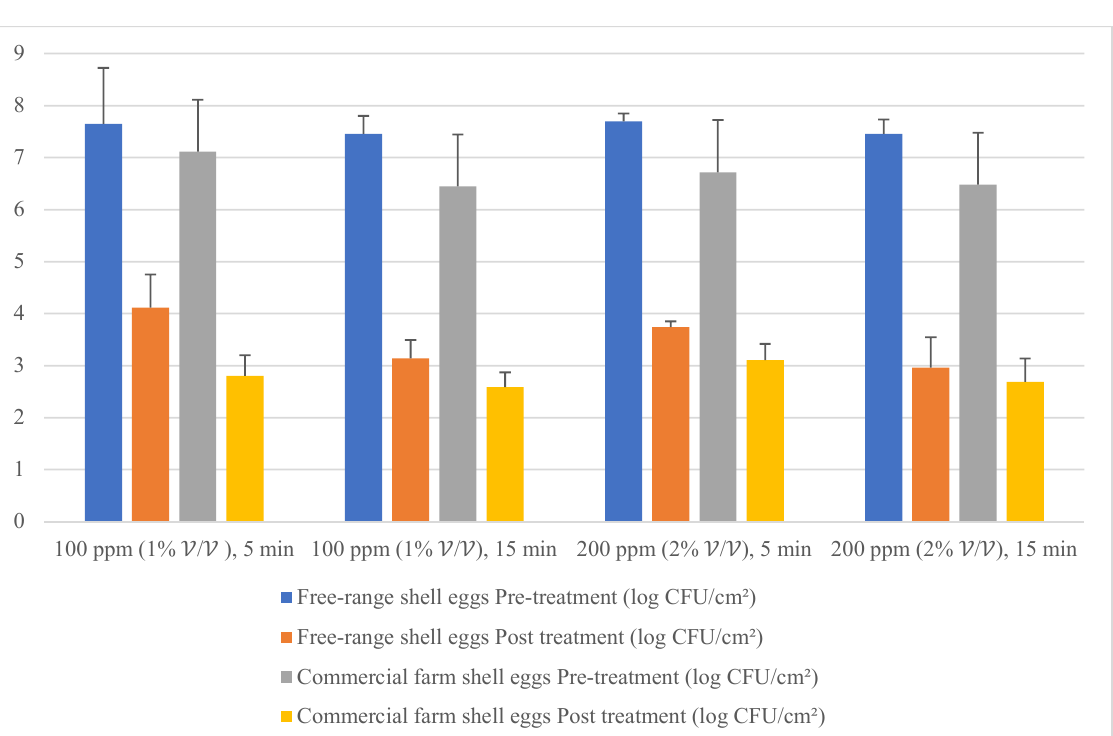
Figure 4. Mean population of aerobic mesophilic bacteria (pre- and post-treatment) for free-range shell eggs and commercial farm shell eggs.